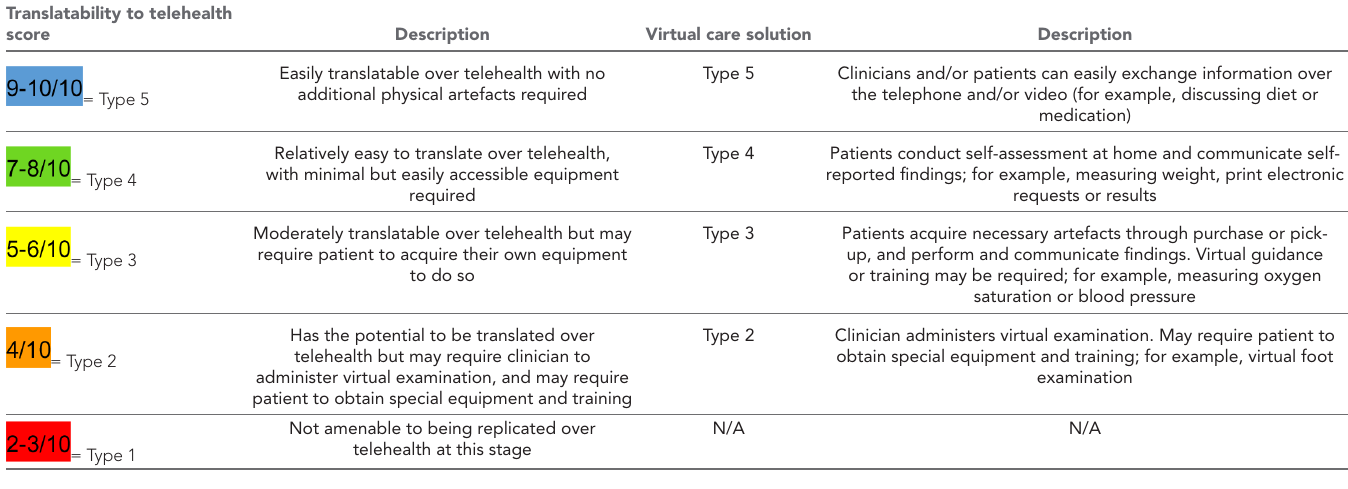
Table 3 Translatability to telehealth score and corresponding virtual care solution type Translatability to telehealth